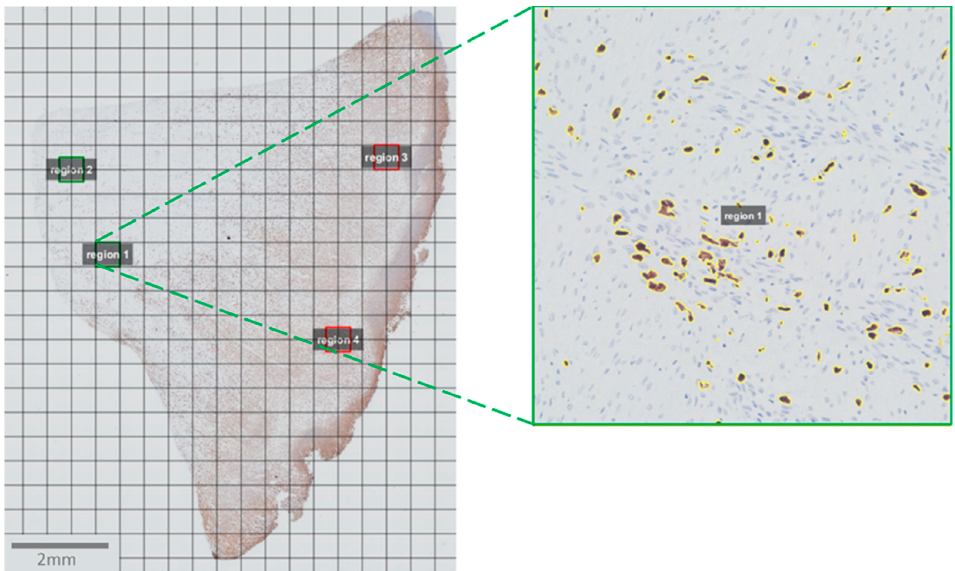
Figure 2. Example of the analysis of the tissue slices in the QuPath software. After importing the scanned images, a grid was placed on the pictures. For each tissue section, four squares of 500 µm × 500 µm were selected: two squares in a fibrotic region (region 1 and 2, green) and two squares in an inflammation region (region 3 and 4, red). On each of these four squares the positive pixel count algorithm was run. Pixels that were counted as positive pixels are encircled in yellow (insert).